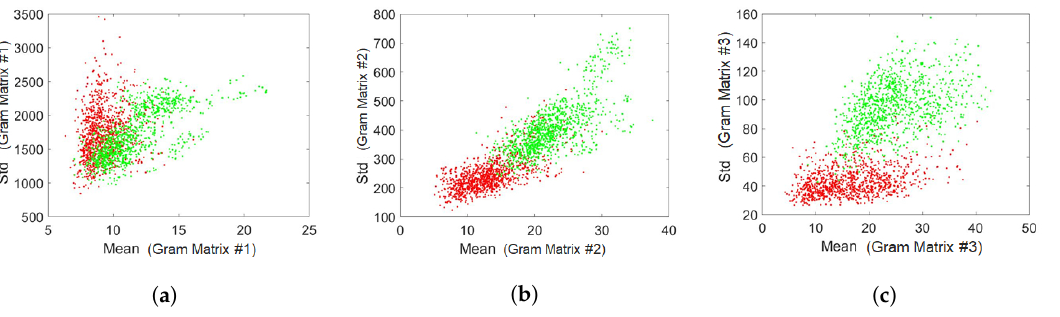
Figure 13. The distribution of mean and standard deviation of: ( a ) The first Gram matrix; ( b ) The second Gram matrix, ( c ) The third Gram matrix (red: live, green: